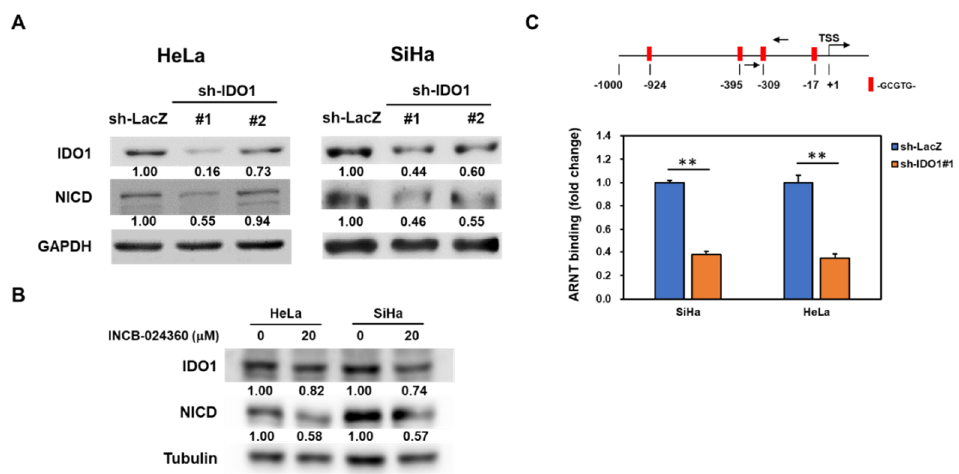
Figure 5. Inhibition of IDO1 in cervical CSCs reduces Notch1 activation. Tumorspheres from HeLa and SiHa cells were dissociated into single cell suspension. ( A , B ) The tumorsphere cells were transduced with lentiviruses carrying IDO1 specific shRNAs (IDO1#1 or IDO1#2) or control LacZ specific shRNA (LacZ) followed by selection with puromycin ( A ) or treatment with 20 µ M of INCB-024360 for 48 h. The expression of NICD or IDO1 was determined by Western blotting. The insert numbers indicated the relative expression level in comparison to sh-LacZ transduced cells. ( C ) The putative binding sites of aryl hydrocarbon receptor / aryl hydrocarbon receptor nuclear translocator (AhR / ARNT) (-GCGTG-) in the Notch1 promoter were analyzed by the EPD website and the binding of ARNT to − 309 site of Notch1 promoter in HeLa and SiHa tumorsphere cells after the knockdown of IDO1 was analyzed by the ChIP method with an anti-ARNT antibody and quantitated by the qPCR method. ** p < 0.01. All the experiments were repeated three times and data from one experiment were presented.